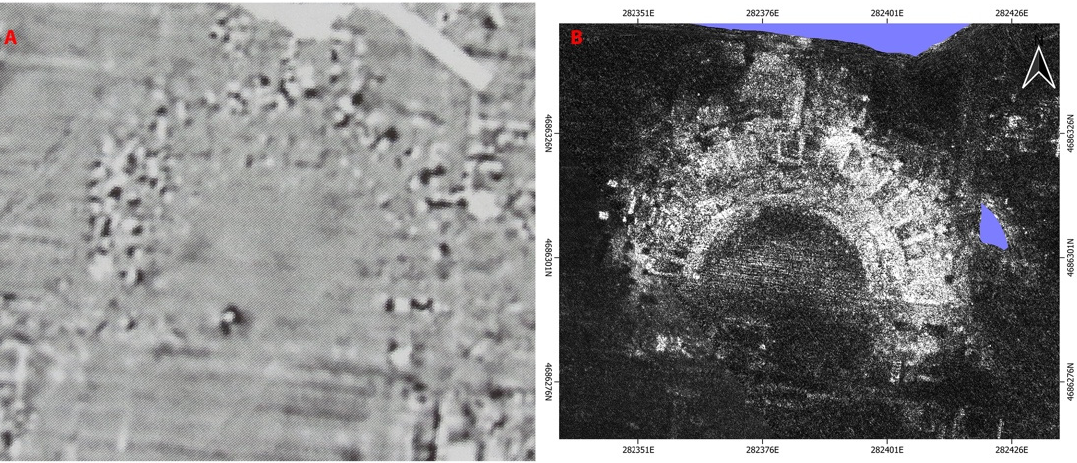
Figure 5. Falerii Novi, detail of the theater from: ( A ) the magnetometer survey [34]; ( B ) the GPR time-slices with higher visibility, between 19–20 ns [28] (image by M. Serpetti).